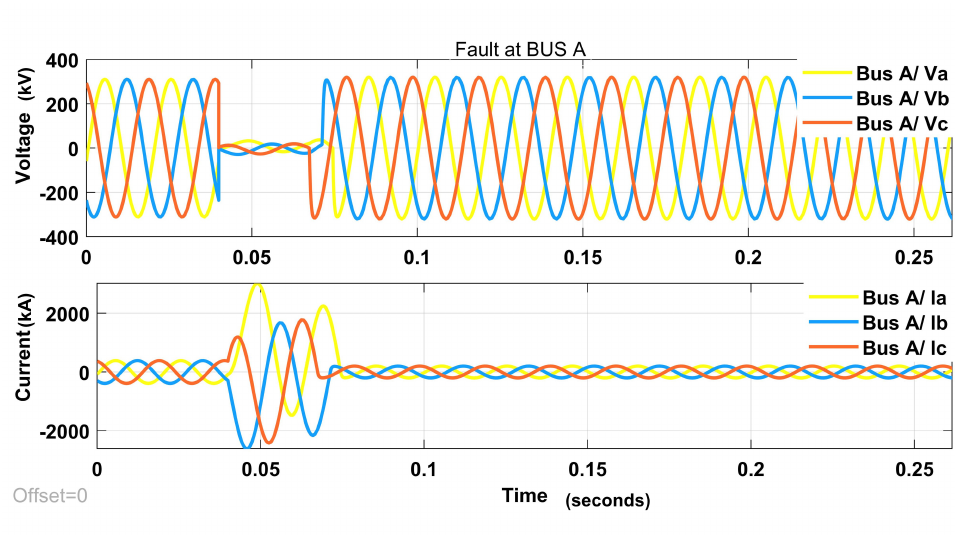
Figure 4. Fault at bus A without the relay.